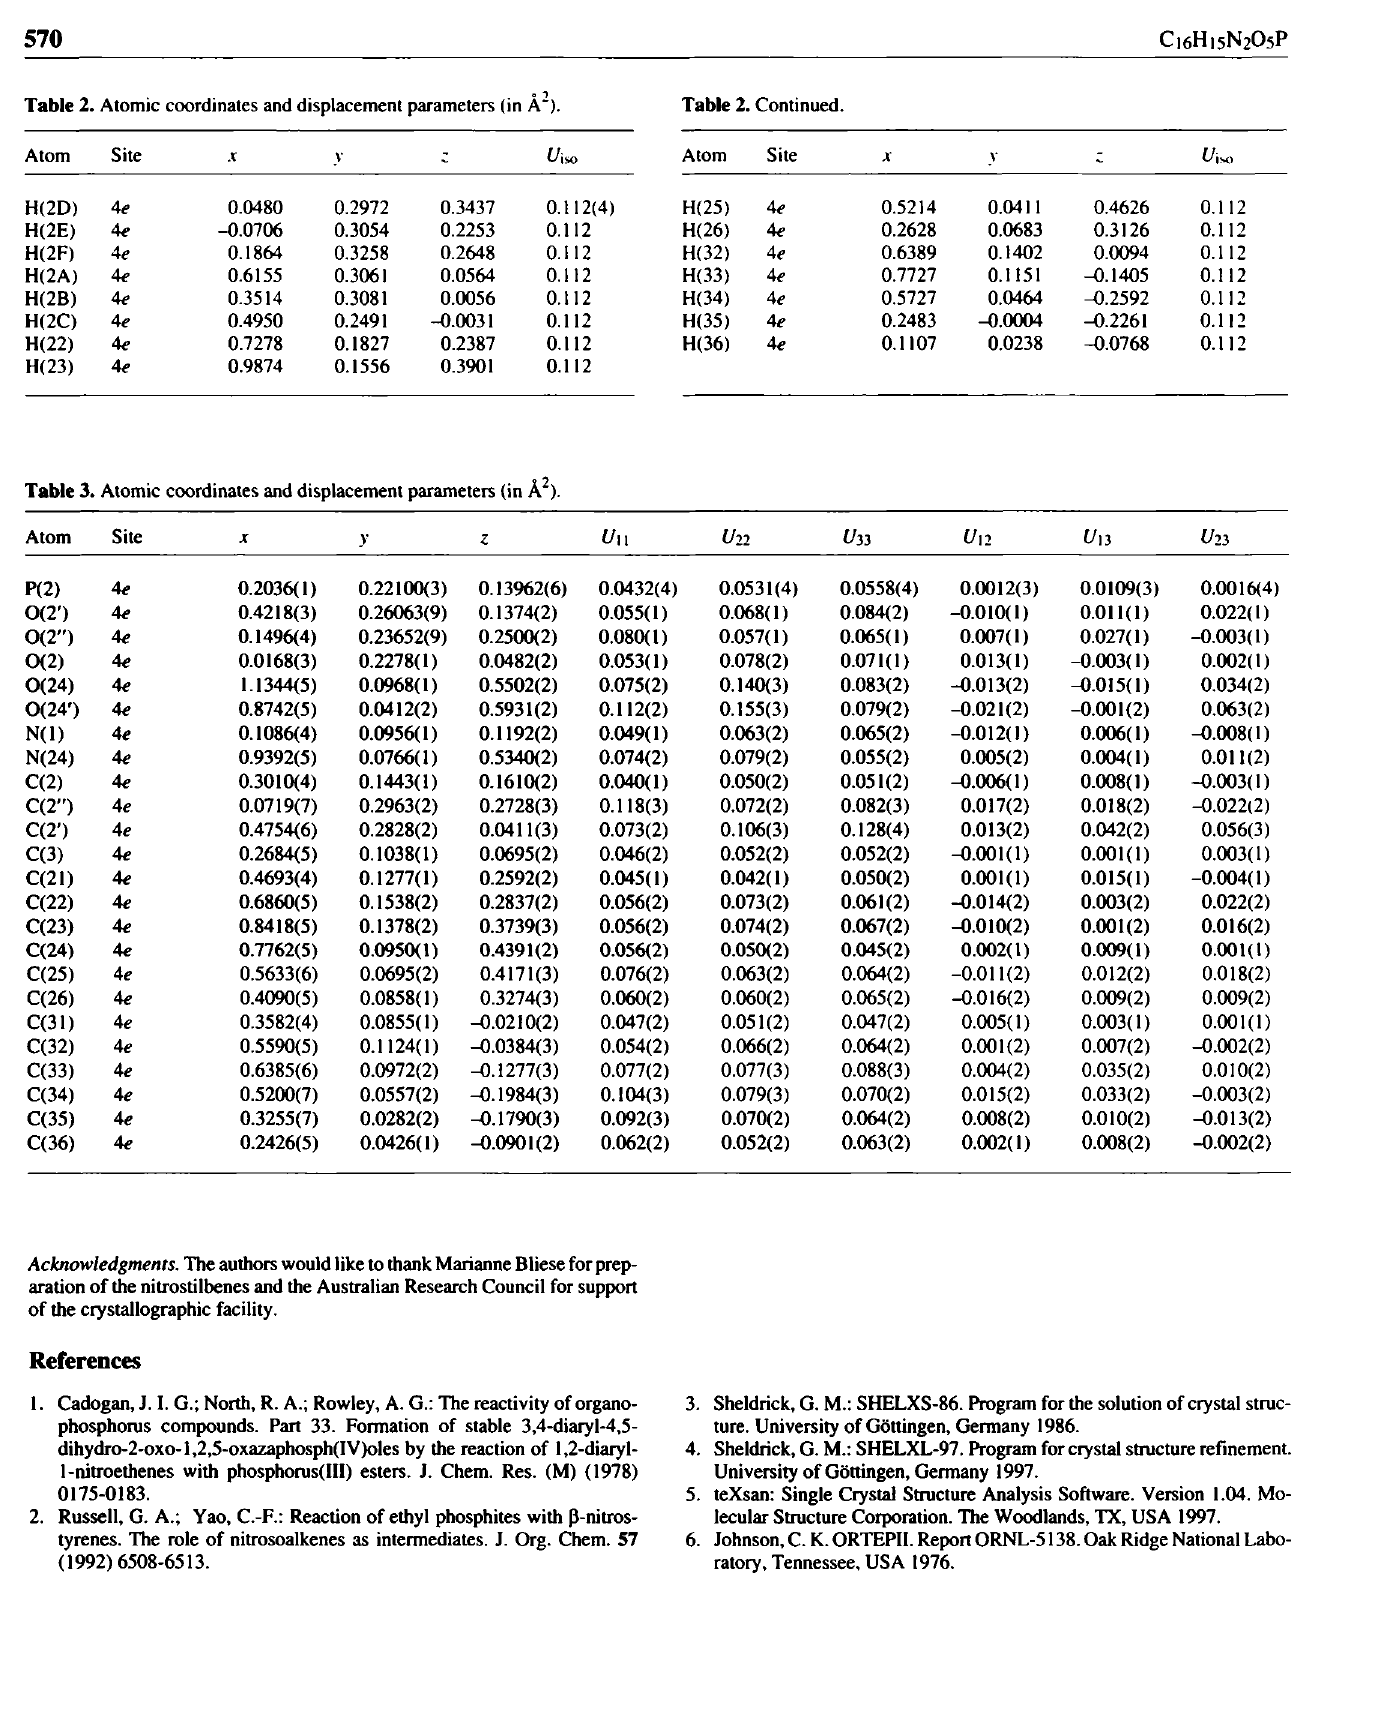
Table 2. Atomic coordinates and displacement parameters (in Ä 2 ).